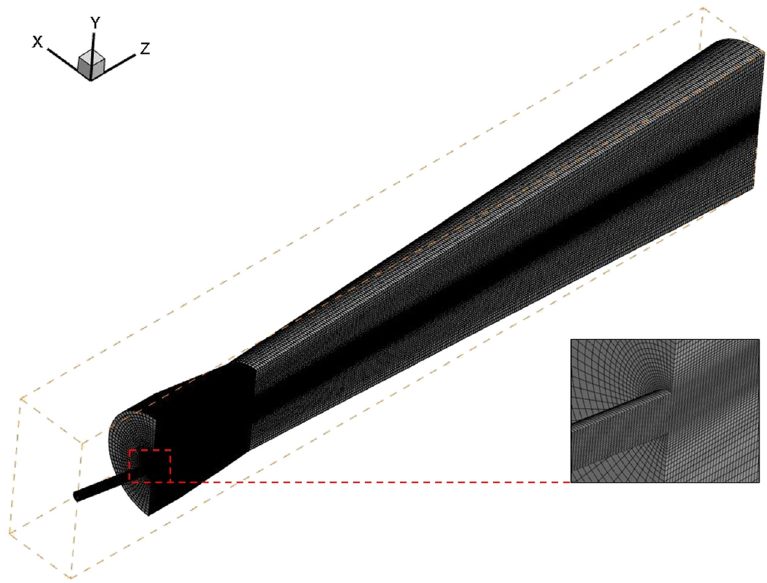
Figure 3: Schematic diagram of computational domain and grid of the model.